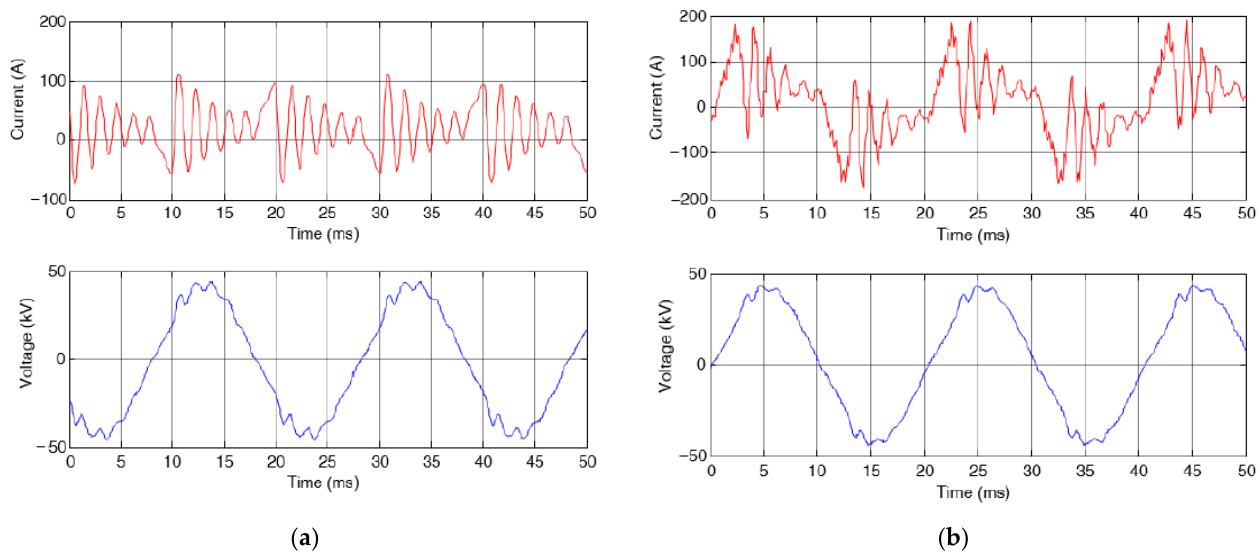
Figure 2. Current and voltage variation : ( a ) When the locomotive is at a distance of over 5 km from the station ; ( b ) When the locomotive is at the station .